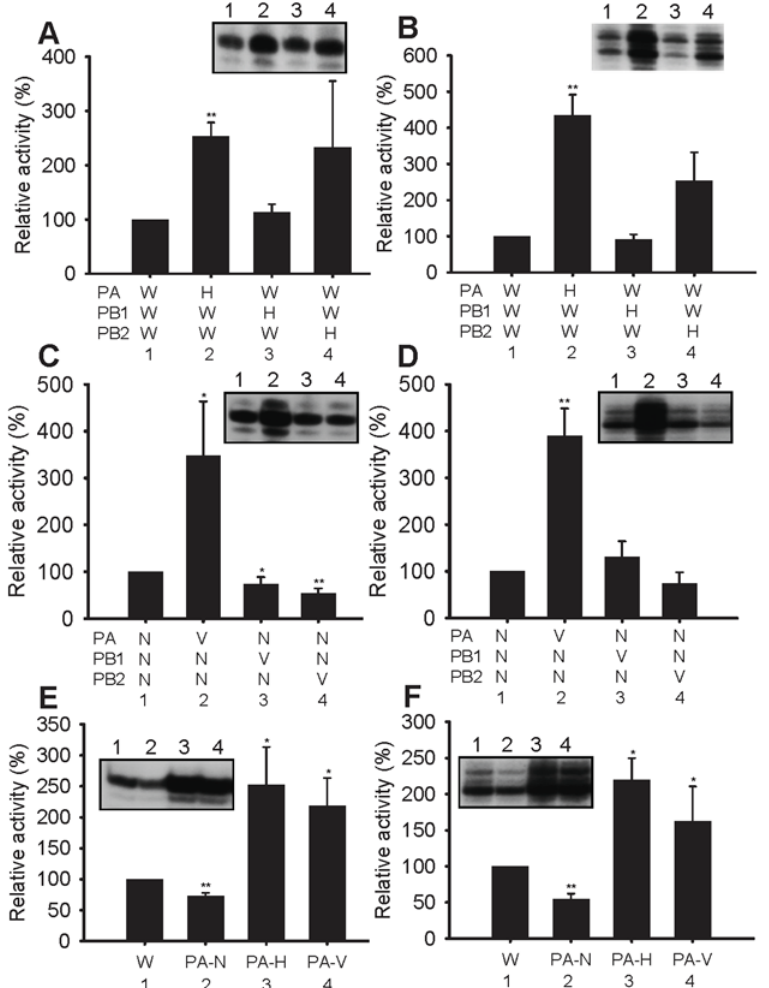
Figure 2. Comparison of activities of polymerase hybrids between H5N1 strains and classical human strains in vitro. (A) and (B) a WSN (W) subunit was replaced with the corresponding HK (H) subunit as indicated in 1–4. (C) and (D) a NT (N) subunit was replaced with the corresponding VN (V) subunit as indicated in 1–4. (E) and (F) The PA subunit of WSN (W) was replaced with either the PA of NT (PA-N), or HK (PA-H) or VN (PA-V). The activity was analyzed by the ApG-primed transcription assay (in A, C and E) and by the globin mRNA-primed transcription assay (in B, D and F). Relative activity is % activity relative to the WSN (W) polymerase from at least 3 independent experiments. Inset square panels show typical gels. * and ** show statistical significance at p , 0.05 and p , 0.01, respectively, in a Student’s